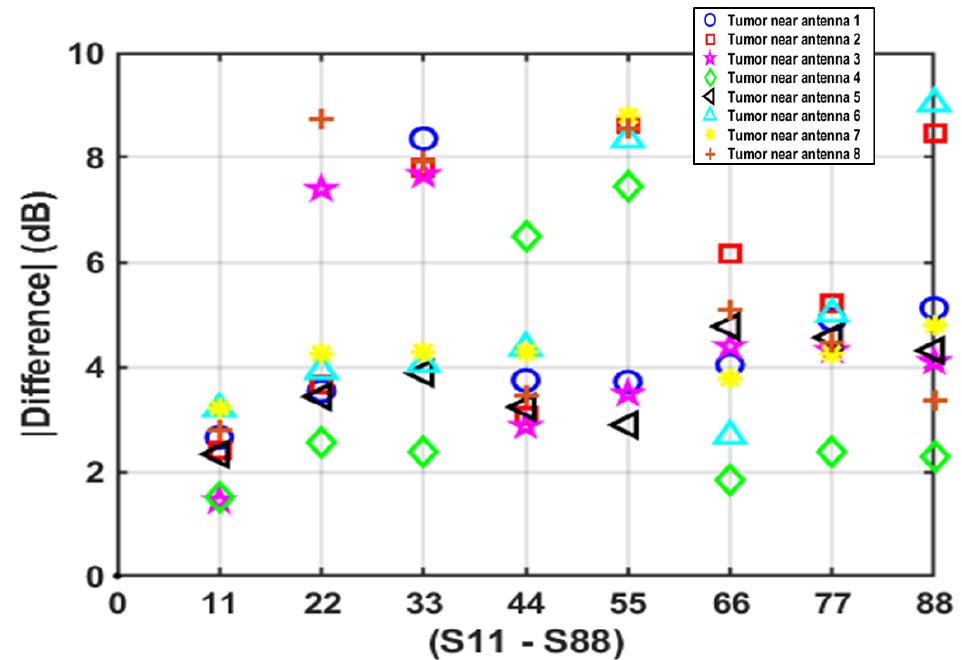
Figure 10. Data pattern showing the difference in reflection coefficient values when tumor is placed at different superficial locations.